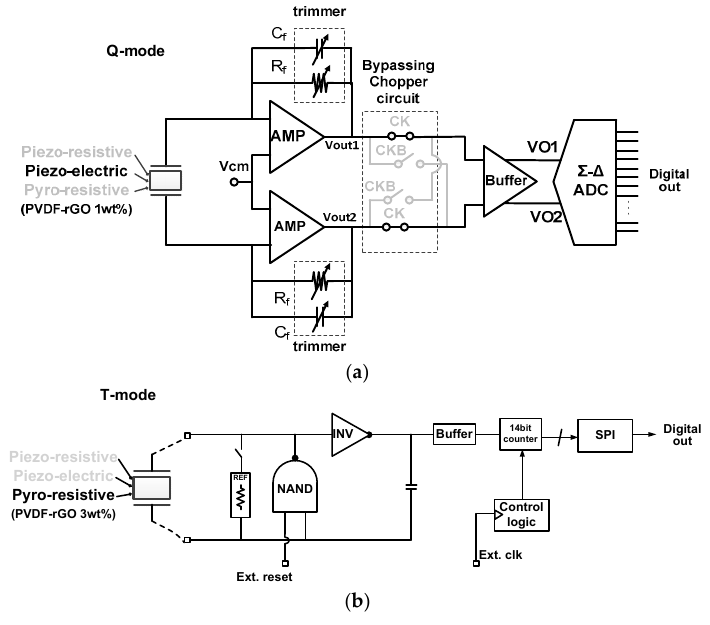
Figure 5. Circuit-level implementations for ( a ) Q mode and ( b ) T mode.